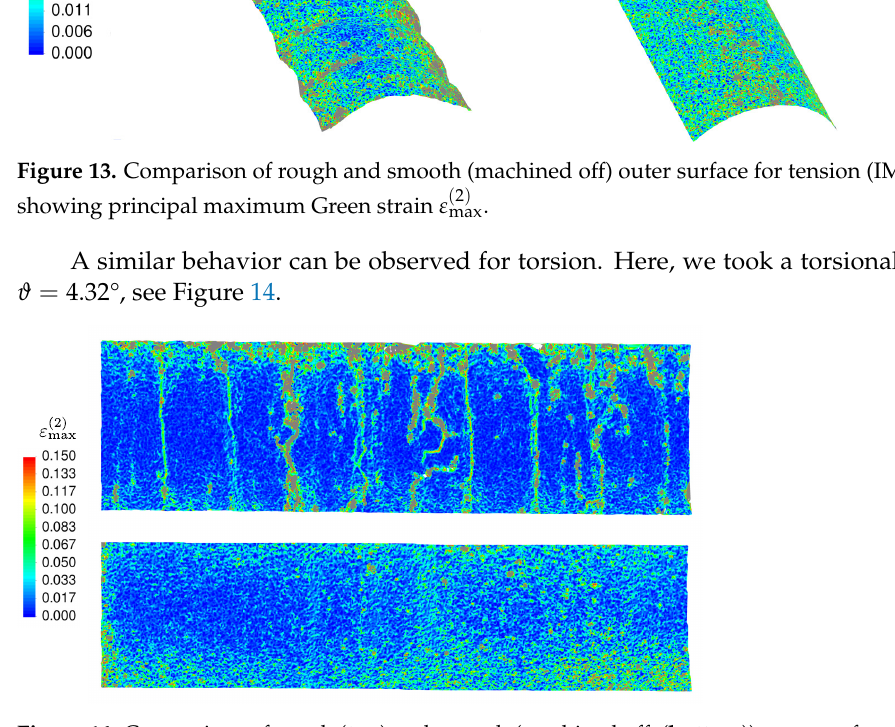
Figure 14. Comparison of rough ( top ) and smooth (machined off; ( bottom )) outer surface for torsion (IMQ + Mon) showing principal maximum Green